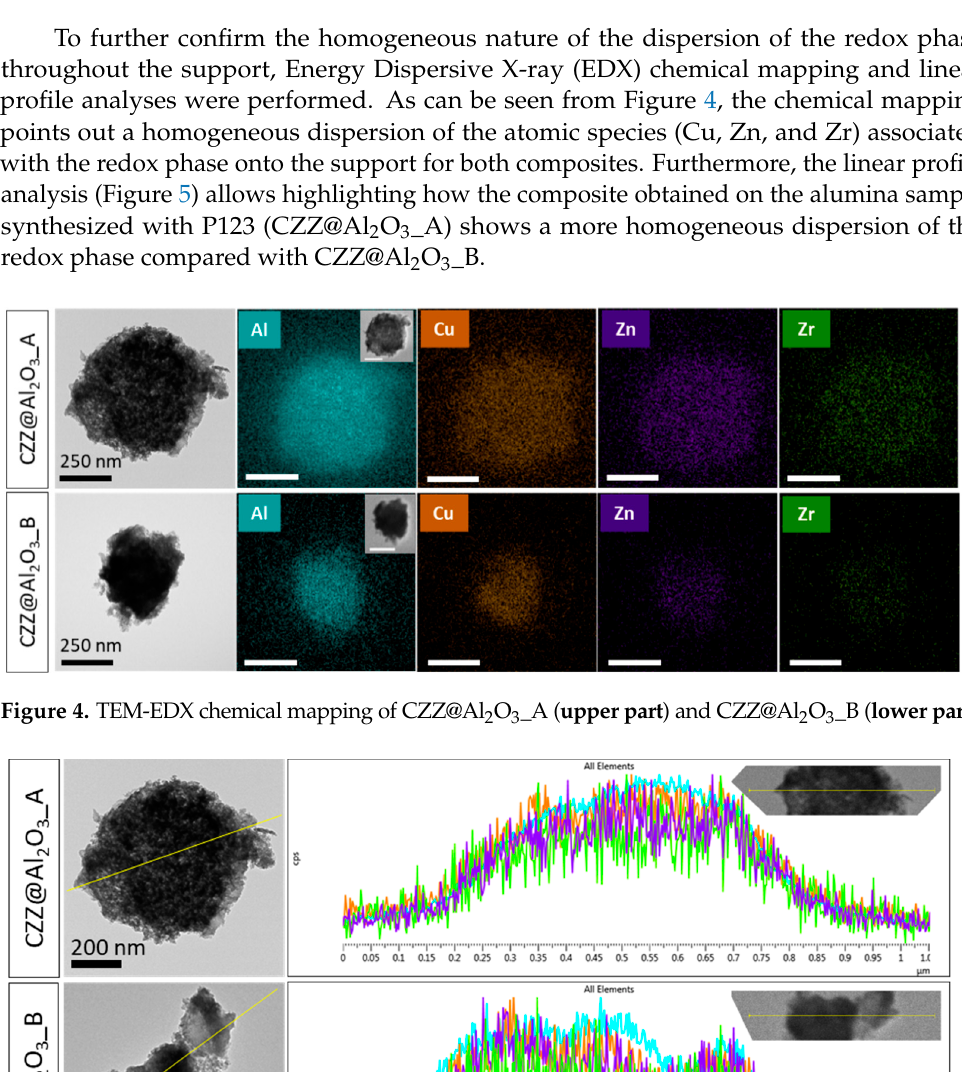
Figure 3. TEM micrographs of Al 2 O 3 _A_400 ( a ), Al 2 O 3 _A_900 ( b ), CZZ@Al 2 O 3 _A ( c ), Al 2 O 3 _B_400 ( d ), Al 2 O 3 _B_900 ( e ), and CZZ@Al 2 O 3 _B ( f ).